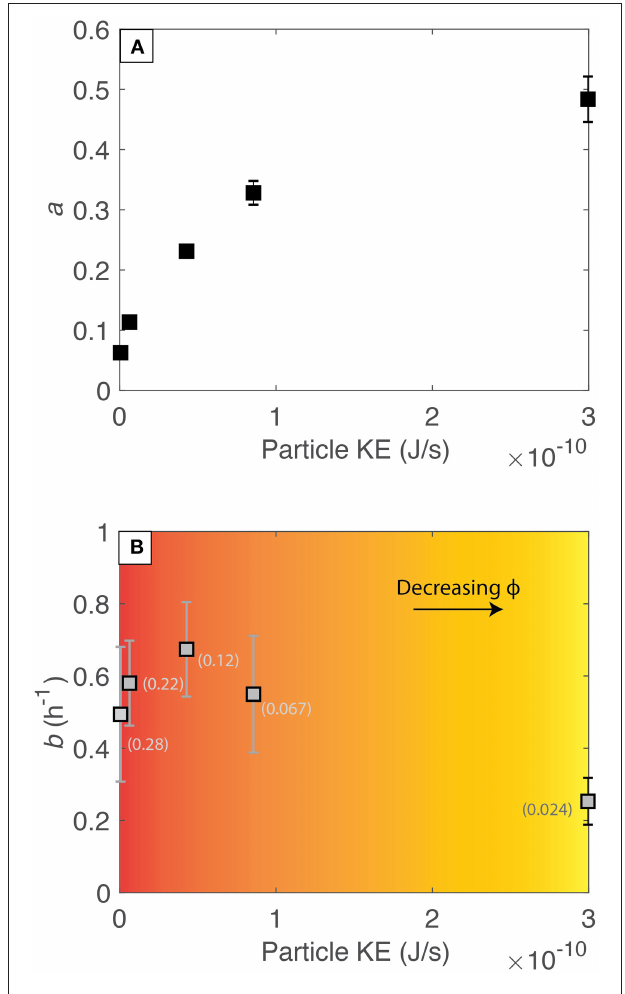
FIGURE 8 | (A) The infinite time production limit, a for all experiments as a function of the amount of kinetic energy (KE) supplied to each particle per second. (B) The attrition rate constant, b for all experiments as a function of the KE supplied to each particle per second. Color shading denotes the decreasing dimensionless particle concentration ( φ ) with increasing KE. The numbers adjacent to the data points correspond to the specific φ for each experiment. Error bars denote one standard